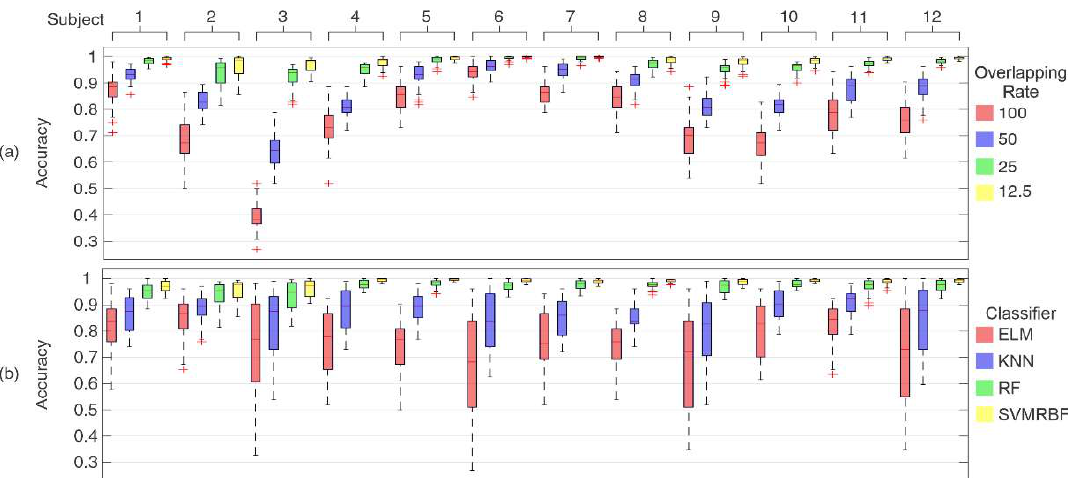
Figure 10. Distribution of accuracies considering the data for each subject individually in the test and training steps. ( a ) Distributions concerning overlap rate and ( b ) distributions concerning classifiers. The bars represent the 25th and 75th percentiles; the whiskers represent approximately 99.3% the coverage of distribution, and the crosses (+) are the outliers.